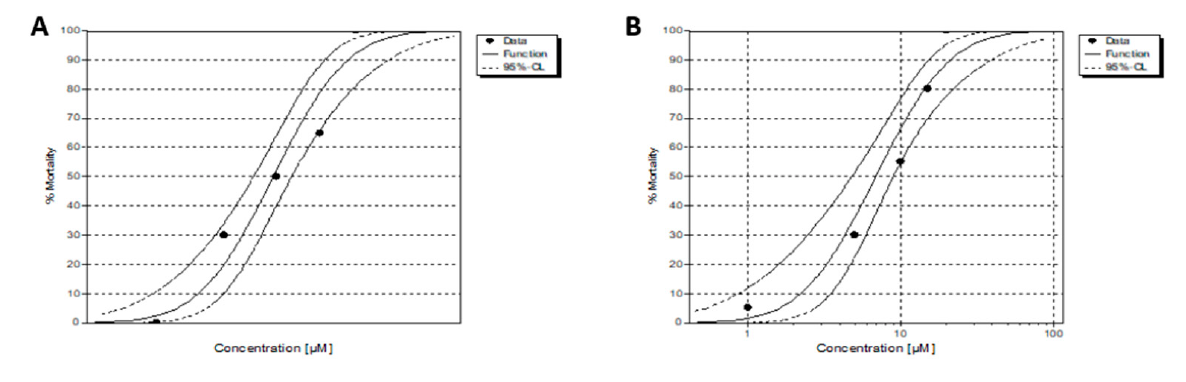
Figure 6. Accumulative mortality over (72 h) for complex Fe1 ( A ) and complex Fe2 ( B ) at the different stages evaluated (in hpf).